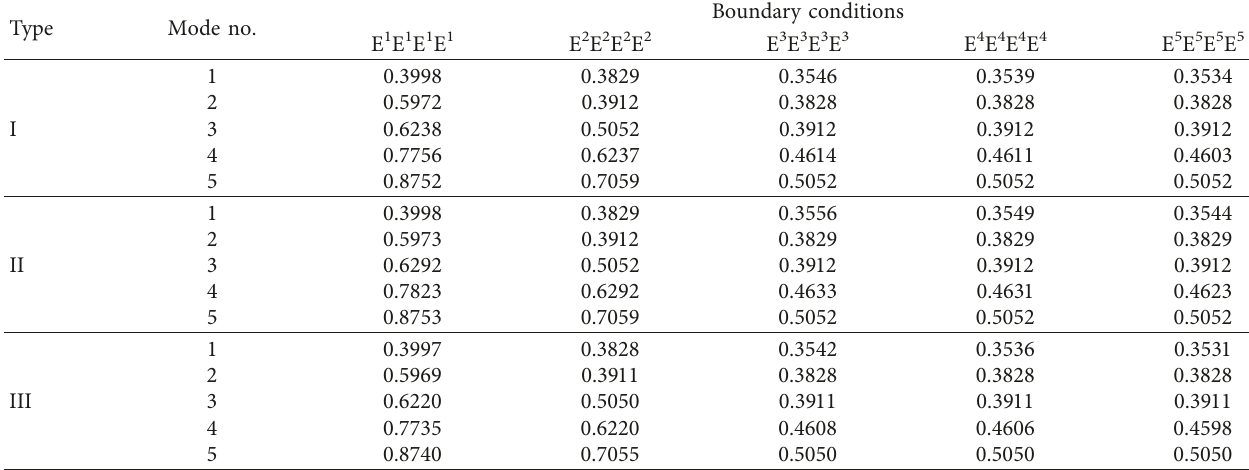
Table 6: Fundamental frequencies for porous rectangular plates subjected to different elastic edge conditions with different porosity